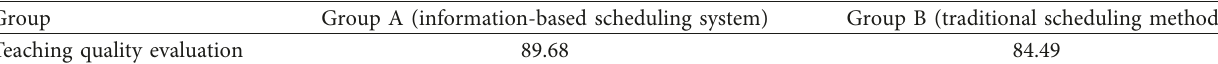
Table 5: Comparison of the effect of the informatization scheduling system on teaching quality. Group